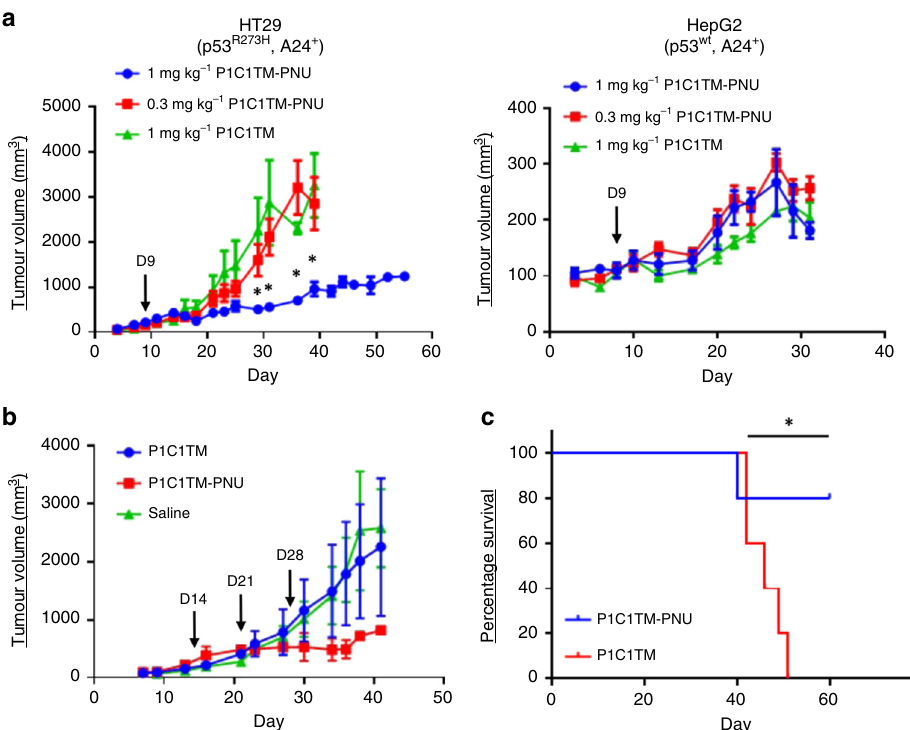
Fig. 7 P1C1M-PNU limits growth of mutant p53-expressing HT29 xenograft in vivo. HLA-A24 expressing a HT29 (p53 R273H ) and HepG2 (p53 wt ) cells were injected subcutaneously into NSG mice. After tumours reached an average size of ≥ 100 mm 3 , mice were treated with a single dose of either P1C1TM-PNU ADC (1 or 0.3 mg kg − 1 ) or unconjugated P1C1TM only (1 mg kg − 1 ) as indicated by the arrows. P1C1TM-PNU signi fi cantly delayed tumour growth as compared to the unconjugated P1C1TM (* represents signi fi cant differences with p ≤ 0.05. Statistical analyses were done by Student ’ s t test with Holm – Š idák method of multiple comparison.). b Mice bearing HT29 (p53 R273H ) tumours were treated with a loading dose of 1 mg kg − 1 of either P1C1TM-PNU or unconjugated P1C1TM only, followed by two more doses at 0.3 mg kg − 1 7 days apart. c HT29 cells were introduced i.v. into NSG mice and treated with